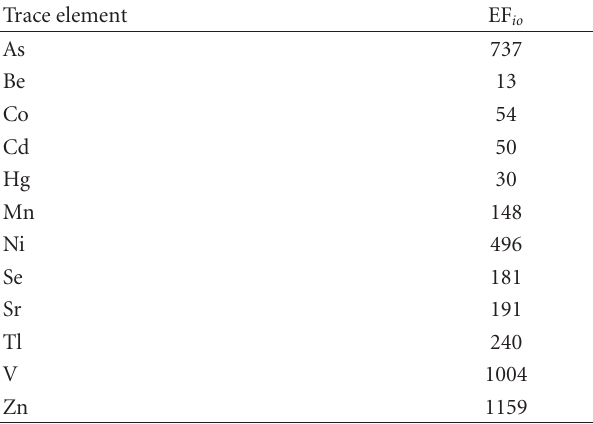
Table 8: Organized emission factors EF io of selected trace elements found for firing the coke oven battery in Carbo-Koks CP, mg/Mg. Trace element EF io As